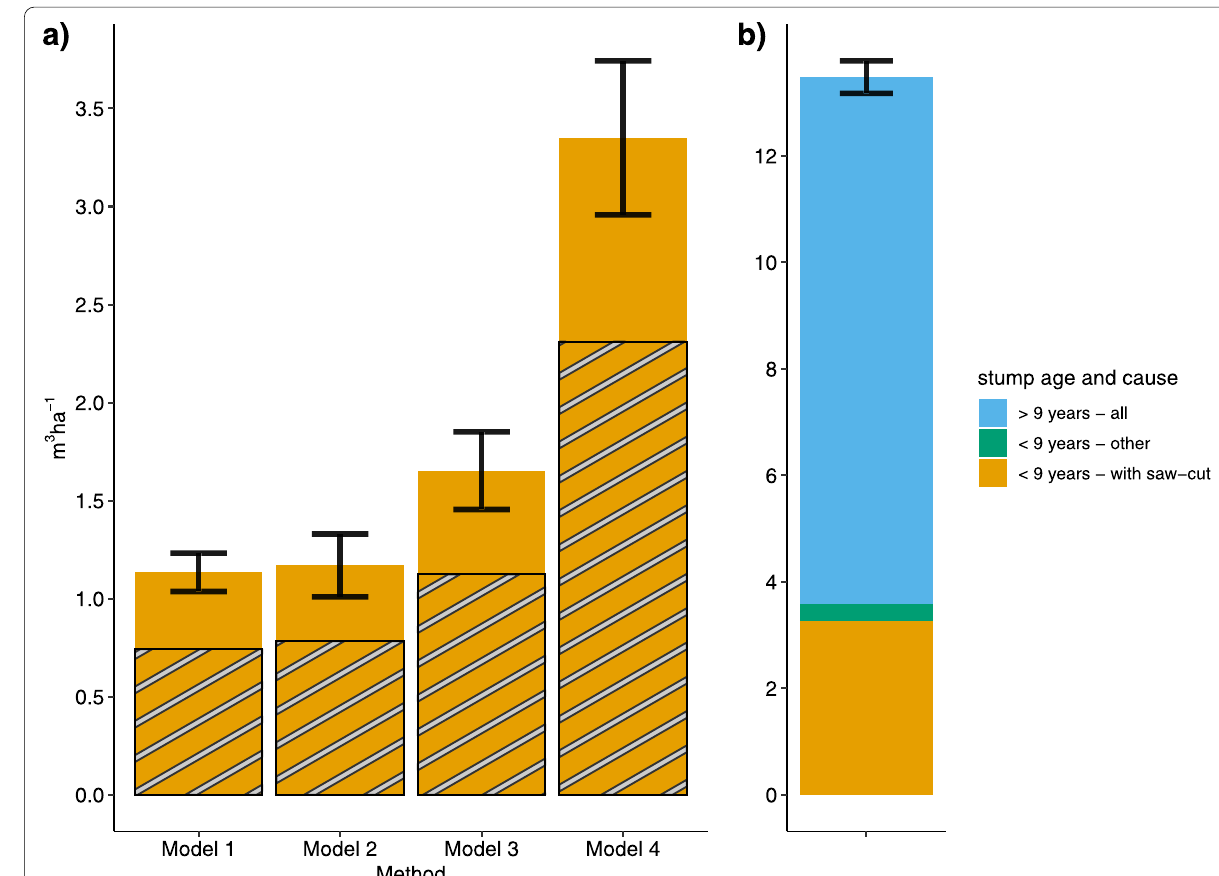
Fig. 3 Stump volume estimates for coniferous (dashed) and broad-leaved tree species based on the NFI5 stump inventory data showing a the effect of the estimation method based on increasing measurement detail for tally trees located in the smaller 200 m 2 intensive monitoring plot that were alive and 12 cm DBH in the NFI4 and had an observed saw-cut below a height of 1.30 m on the NFI5. Model 1 corresponds to a cylinder ≥ based on a stump diameter corresponding to the DBH of tree from the previous inventory and a height of 30 cm, model 2 to a cylinder based on a stump diameter corresponding to the DBH of tree from the previous inventory and the measured upslope height, model 3 to a cylinder based on the measured upper stump diameter and the upslope height, model 4 to a truncated cone using two diameter (at stump top and half the downslope height) and two height (upslope and downslope) measurements (see Fig. 1), and b model 4 volume as totals for all tree species for all measured stumps, including also older stumps, i.e., which existed as stumps for more than 9 years, i.e., before the NFI4. The error bars indicate one standard error of the total volume of stumps of conifer and broadleaf tree species. Note the different ranges of the y-axes. The data are based on common sample plots as in Fig. 2